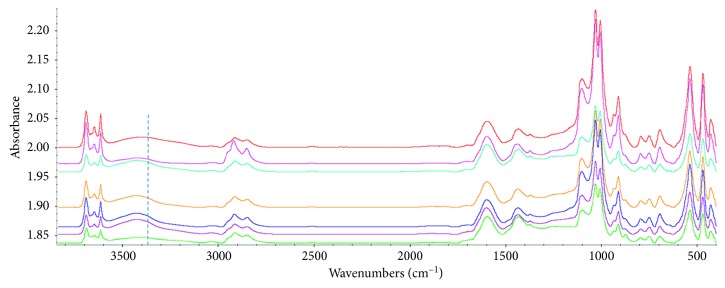
FTIR spectra of all coal samples (from top to bottom along the dotted line were the FTIR spectra of IL-untc, [N8,8,8,1]Cl-tc, [N2,2,2,2]Cl-tc, [C12MIm]Br-tc, [C14MIm]Br-tc, [HOEtMIm][BF4]-tc, and [HOEtMIm][NTf2]-tc).